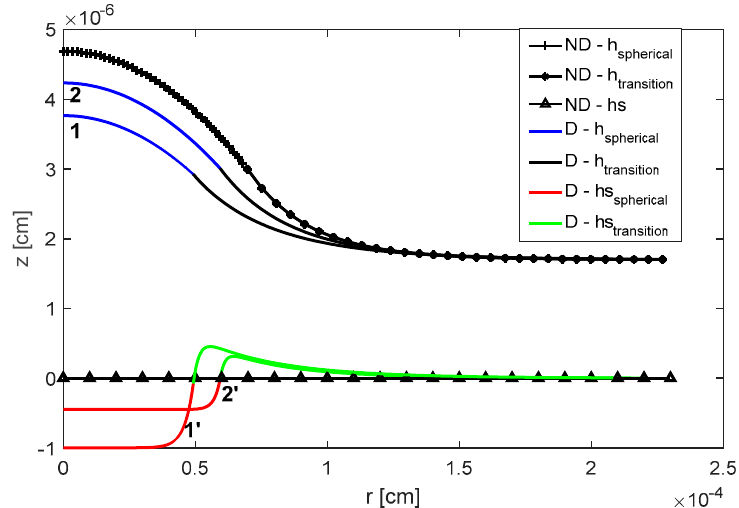
Figure 5. Computed shapes of the droplet and deformation of the substrate: 1, 1 (cid:48) − K = 1 × 10 − 11 cm 3 /dyne and 2, 2 (cid:48) − K = 4.5 × 10 − 12 cm 3 /dyne. ND, Non-Deformable substrate; D, Deformable substrate [18]. Reproduced with permission from [18]. Copyright © 2017 Elsevier B.V.